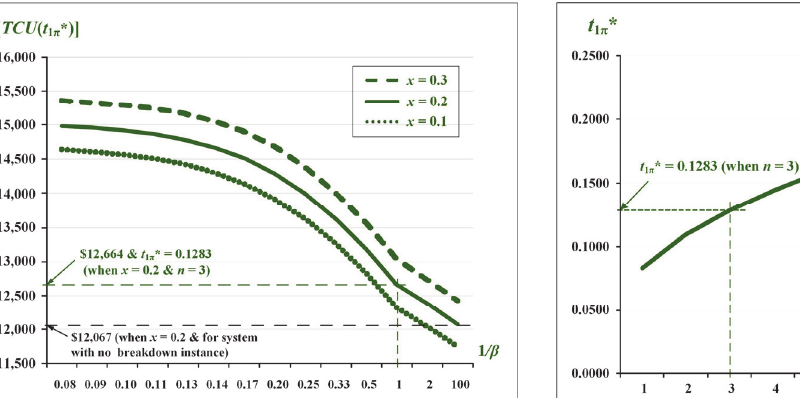
Fig. 11. Effect of changes in n on t 1 π *